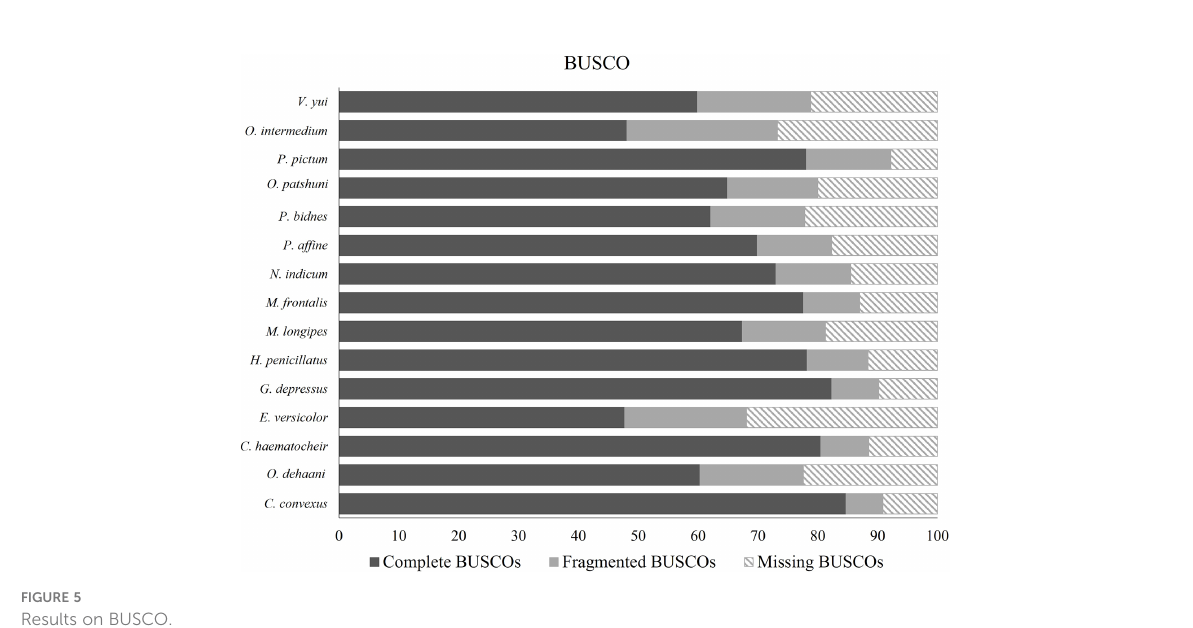
FIGURE 5 Results on